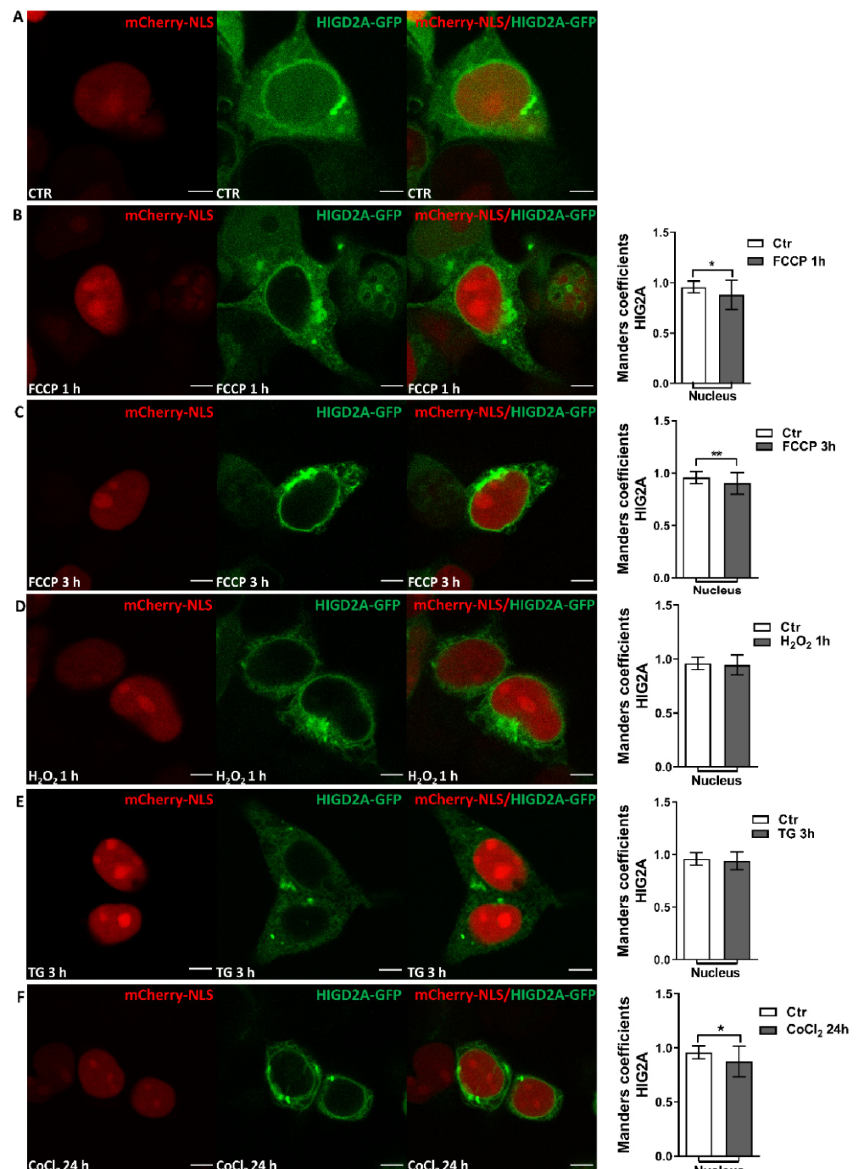
Figure 4. The effect of mitochondrial stress on the nuclear subcellular localization of HIG2A. The representative images of live HEK293 cells that were transfected with pcDNA3.1+/HIG2A-GFP (green) and pmCherry-C1 mCherry-NLS (red fluorescent protein with nuclear localization signal). The cell line was subjected to mitochondrial stress for 1-h and 3-h with FCCP (20 µM) ( B , C ); endoplasmic reticulum stress for 3-h with Thapsigargin (TG) (1 µM) ( E ); oxidative stress for 1-h with H 2 O 2 (100 µM) ( D ), and chemical hypoxia for 24-h with Cobalt (II) (CoCl 2 ) Chloride (100 µM) ( F ). The control (Ctr) ( A ) is the post-transfection basal condition. The Z-axis series (Z-axis) were obtained using confocal microscopy (Olympus FluoView FV1000 Spectral, Olympus Corp., Tokyo, Japan). The quantification of colocalization was performed using Manders’ coefficient (M2: HIG2A/Nucleus). Each bar graph represents the mean ± SE. The number of biological replicates for each condition (n) and number of cells that were analyzed in total (N°): Ctr n = 4, N° = 23 ( A ); FCCP 1 h n = 3, N° = 22 ( B ); FCCP 3 h n = 4, N° = 27 ( C ); H 2 O 2 n = 3, N° = 28 ( D ); TG n = 3, N° = 20 ( E ); CoCl 2 n = 2, N° = 19 ( F ), were analyzed by a one-tailed t -test ( p < 0.05), followed by a Mann-Whitney test. Statistical differences were found with a significance of p -value (* p -value ≤ 0.0106 ( B ), ** p -value ≤ 0.0061 ( C ), * p -value ≤ 0.0142 ( F )). * Significant (0.01 to 0.05). ** Very significant (0.001 to 0.01). The white bars indicate a 5 µ m